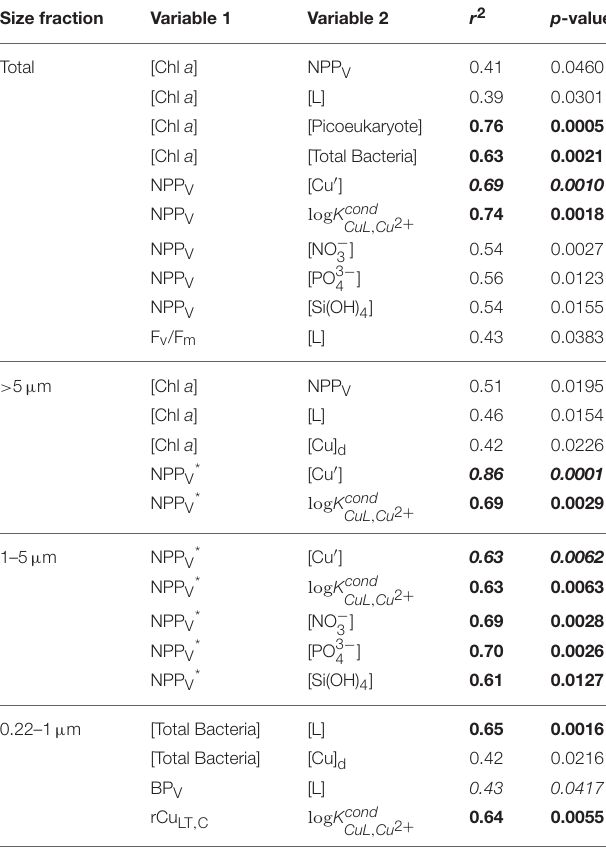
TABLE 6 | Statistically significant Pearson correlations of biomass, productivity, Cu uptake, and chemical parameters measured along Line P in August